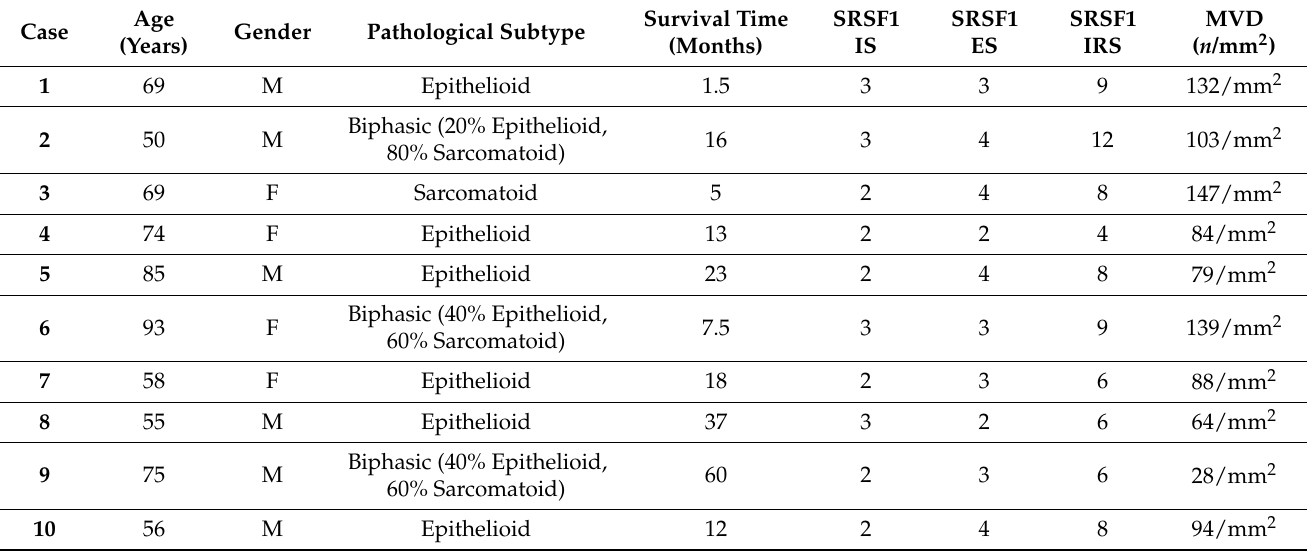
Table 1. Clinico-pathological and immunohistochemical features of the MPM cases.